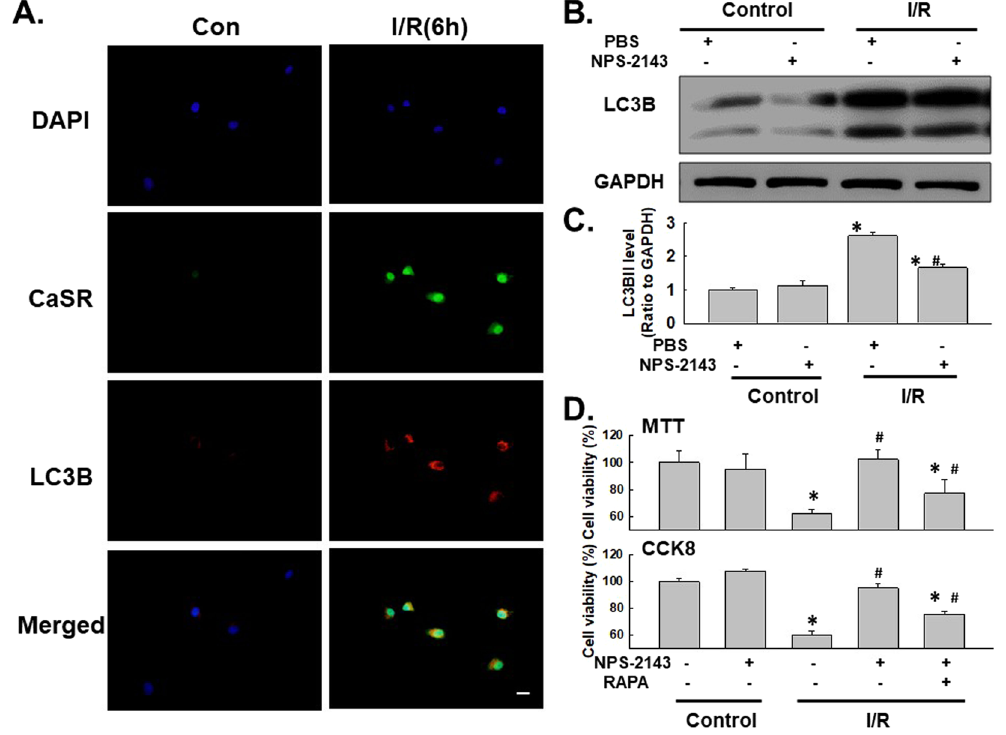
Figure 6. Autophagy mediated the effect of CaSR on I/R-induced cell apoptosis. ( A ) Representative images of immunocytochemical staining showing that CaSR co-localized with the autophagy marker LC3B in HUVECs following I/R injury. The I/R-induced increase in the level of LC3B, but not CaSR, was attenuated by NPS-2143 pretreatment. Scale bar, 20 μ m. ( B ) Representative blots showing that NPS-2143 pretreatment attenuated the I/R- induced increase in LC3B expression. ( C ) Densitometric analyses of LC3B expression from four independent experiments; * p < 0.05 compared with the control group, # p < 0.05 compared with the I/R group. ( D ) MTT assay showing that the rescue effect of NPS-2143 on HUVECs subjected to I/R injury was reversed by treatment with rapamycin. n = 6, * p < 0.05 compared with the control group, # p < 0.05 compared with the I/R group.